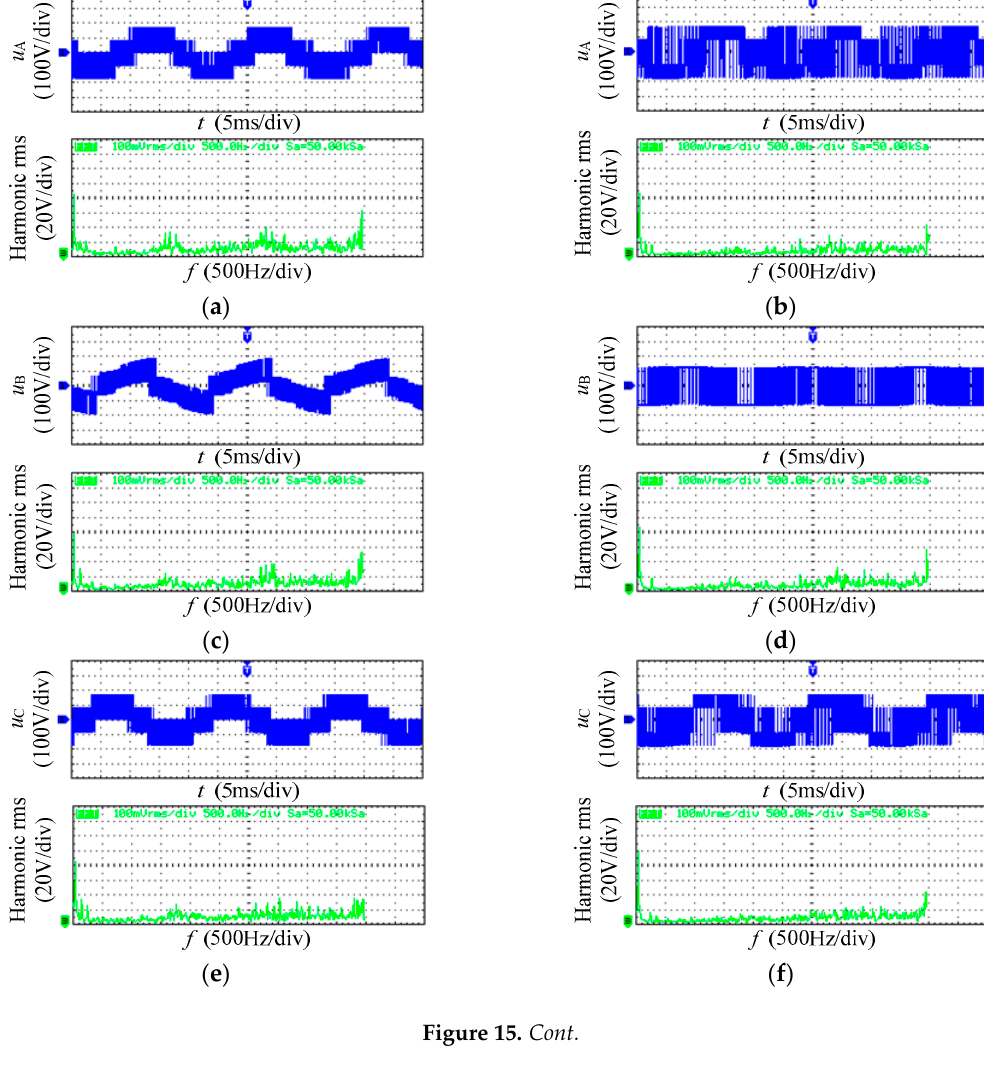
Figure 14. Experimental device.